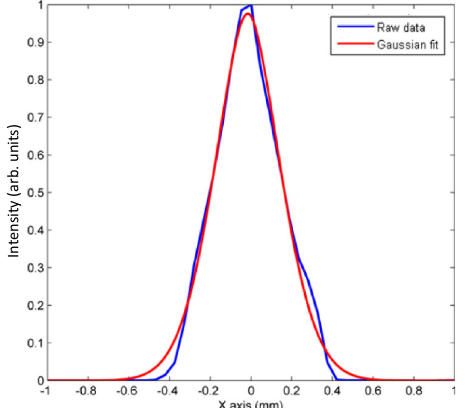
Fig. 8 Beam pro fi le of 1070 nm IPG LIDT test laser. Beam pro fi le is collected using a Primes focus monitor. The focus monitor has a metal tip with a 20 μ m-diameter pinhole in the side. The rotating tip then traverses the entire area of the beam, collecting 2-D data of the beam pro fi le. Blue line represents the raw data from the x-axis of the beam. The blue (red) line is the data (Gaussian fi t).